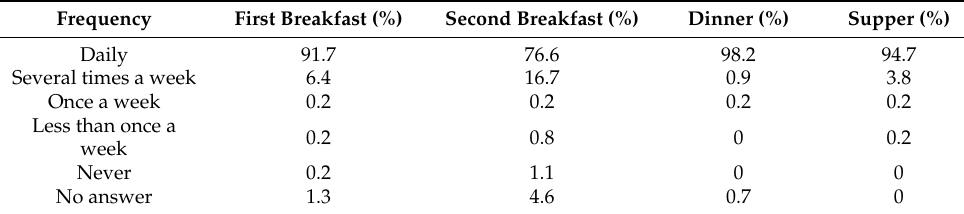
Table 2. The frequency of consumption of meals by children surveyed.